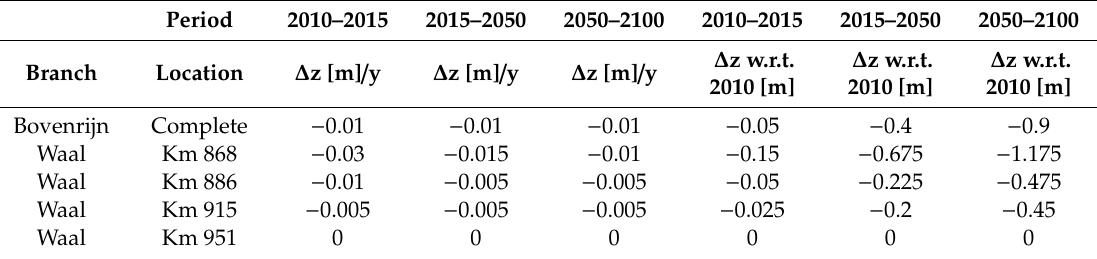
Table 4. Forecast of bed-level changes in Bovenrijn and Waal branches (copyright [26]).